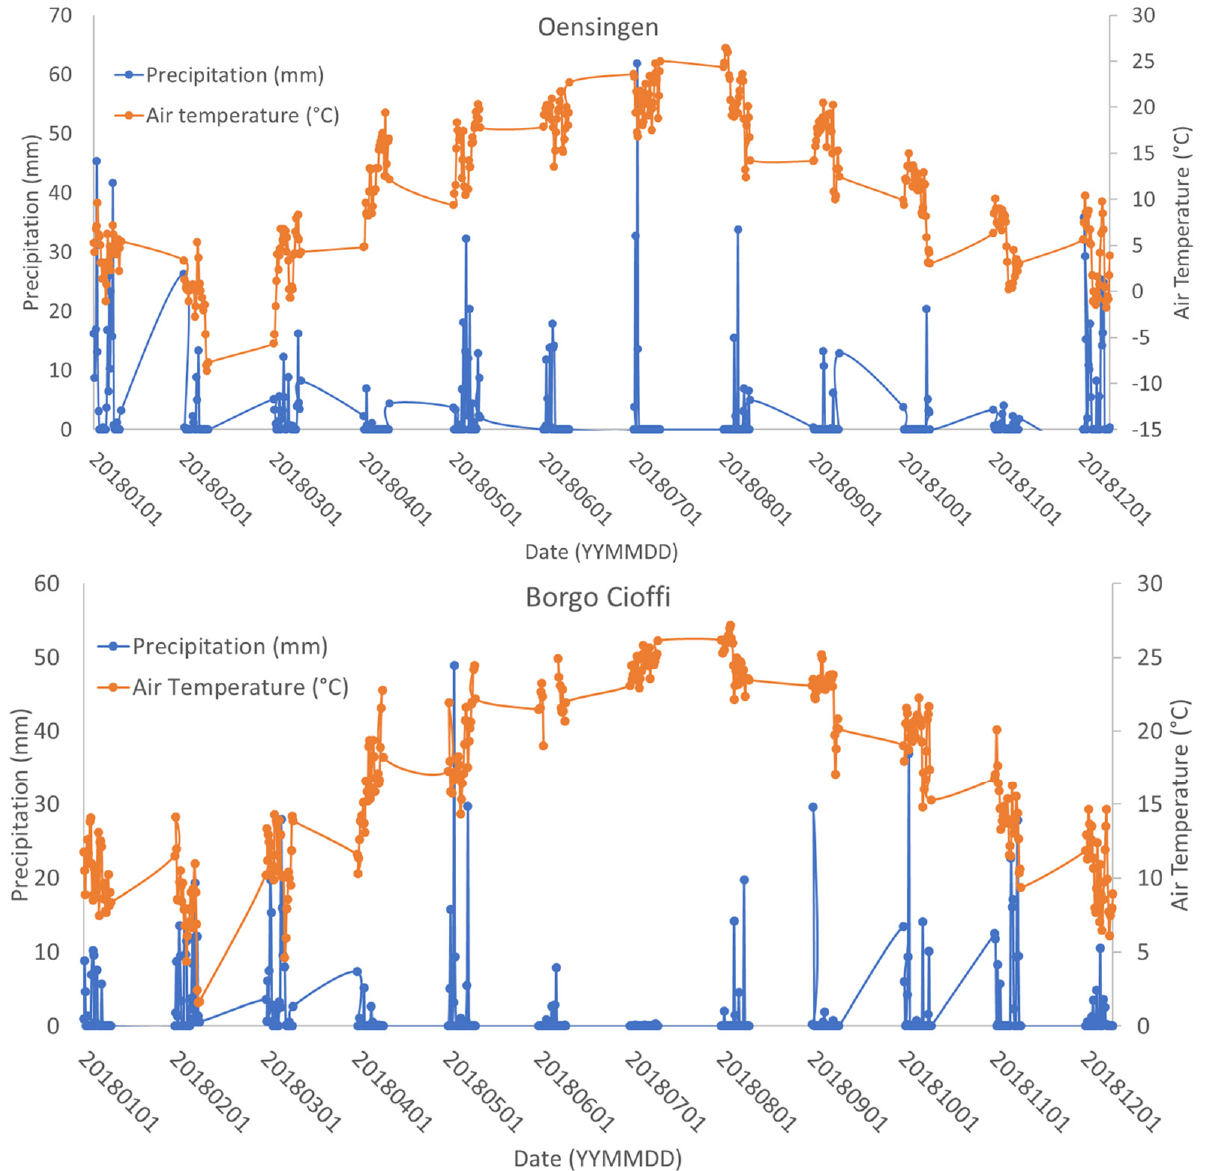
Figure 2. Daily mean precipitation (in mm) and air temperature (in °C) for the year 2018 at both studied sites.